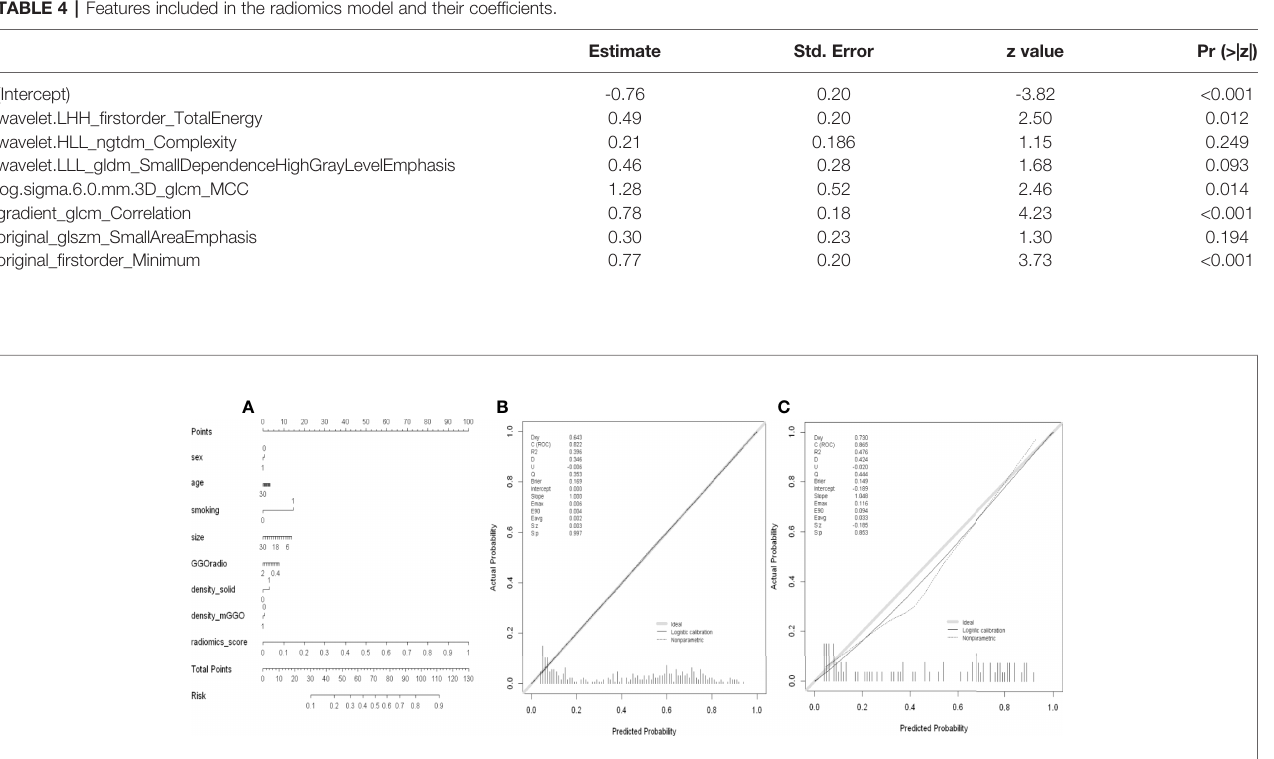
FIGURE 6 | (A) Nomogram of MixModel for predicting presence of spread through air spaces(STAS). For each patient, draw a vertical line between the variable value and the corresponding point line, and then assign a score for each variable based on the clinical and imaging characteristics to obtain a total score. The risk of STAS can be predicted according to the total score. (B) Calibration curve for the MixModel in training cohort. (C) Calibration curve for the MixModel in validation cohort.